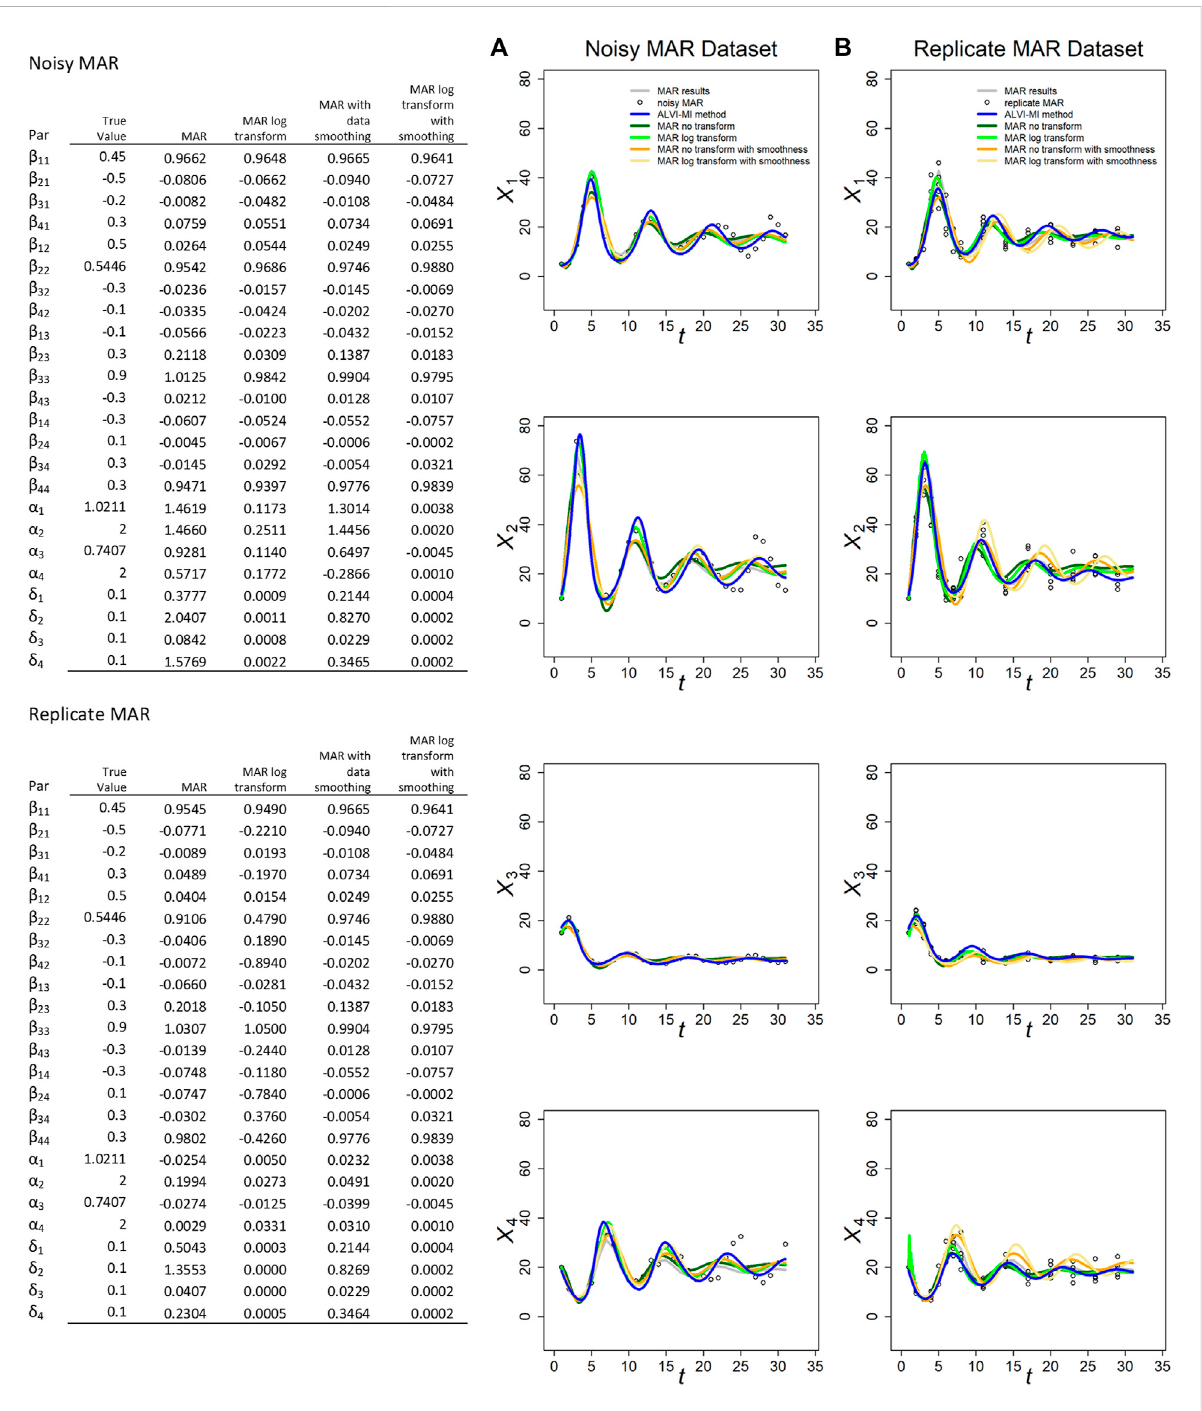
FIGURE 2 MARSS and ALVI-MI methods applied to noisy (A) and replicate (B) MAR datasets with process noise. Original synthetic data are shown as gray dots, data with added noise as black circles. MAR estimates are presented in green, orange and yellow. LV estimates are in blue. The variables of the noisy dataset were smoothed with 15DF-splines and theLV solution was calculated with spline points at times 2, 4, 7, 22, and 27. The variables of the replicate dataset were smoothed with 11DF-splines and the LV solution was calculated with spline points corresponding to times 2, 3, 4, 5 and 12. Data and parameter estimates for LV can be seen in Supplementary Table S5. SSEs for these fi ts are presented in Table